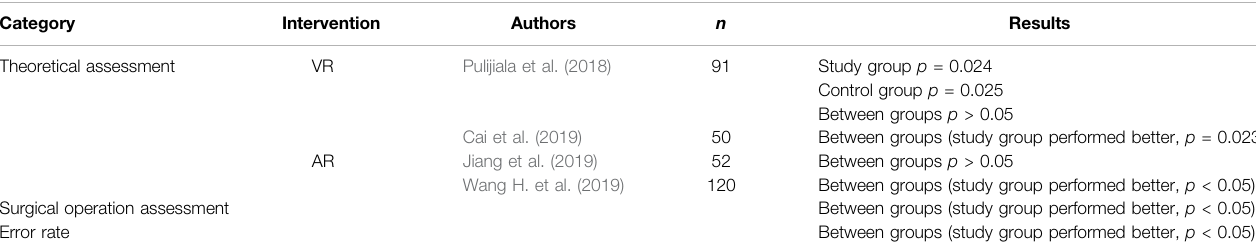
TABLE 2 | Compared with the traditional